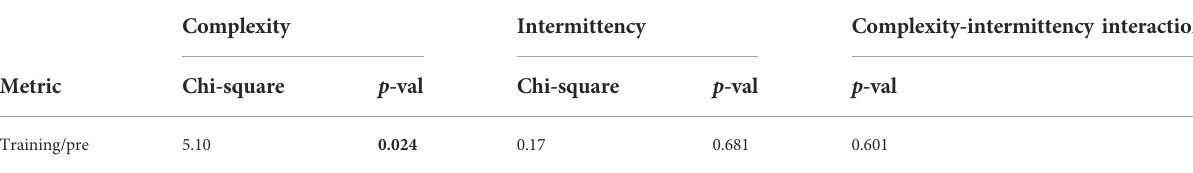
Table 5C: Post hoc comparisons, p -value, between visual feedback modes for EDA activity — training/pre